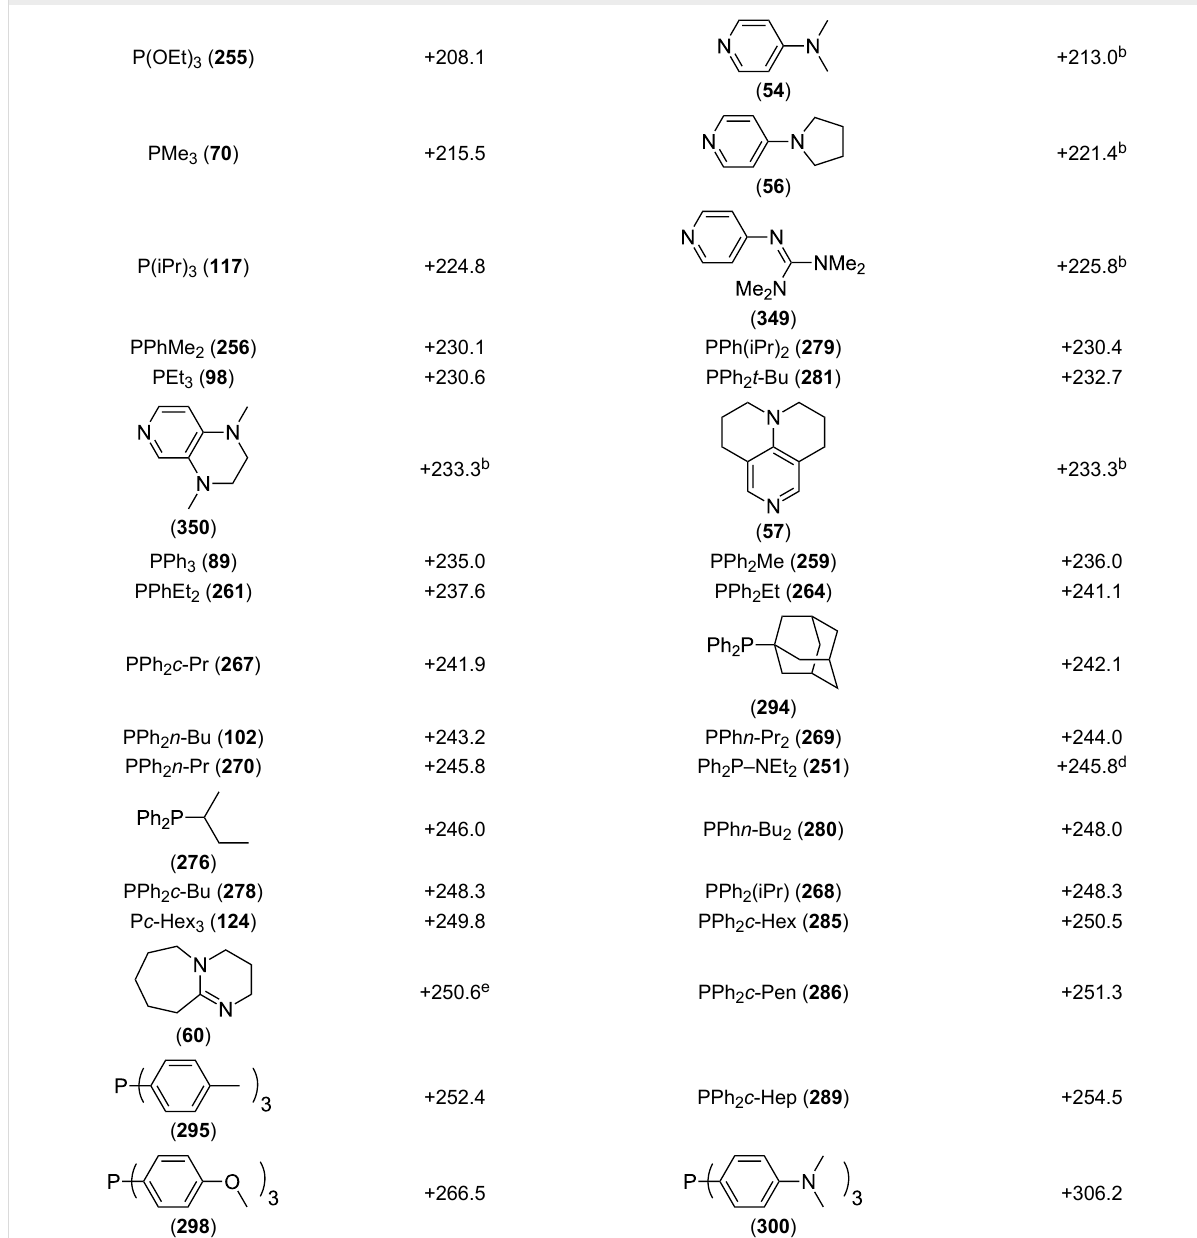
Table 9: BHCA values of Lewis base, ordered by increasing BHCA values.